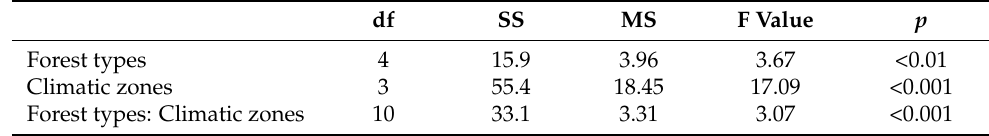
Table 2. Statistics of GLMM relating climatic, vegetation, and soil variables with τ.